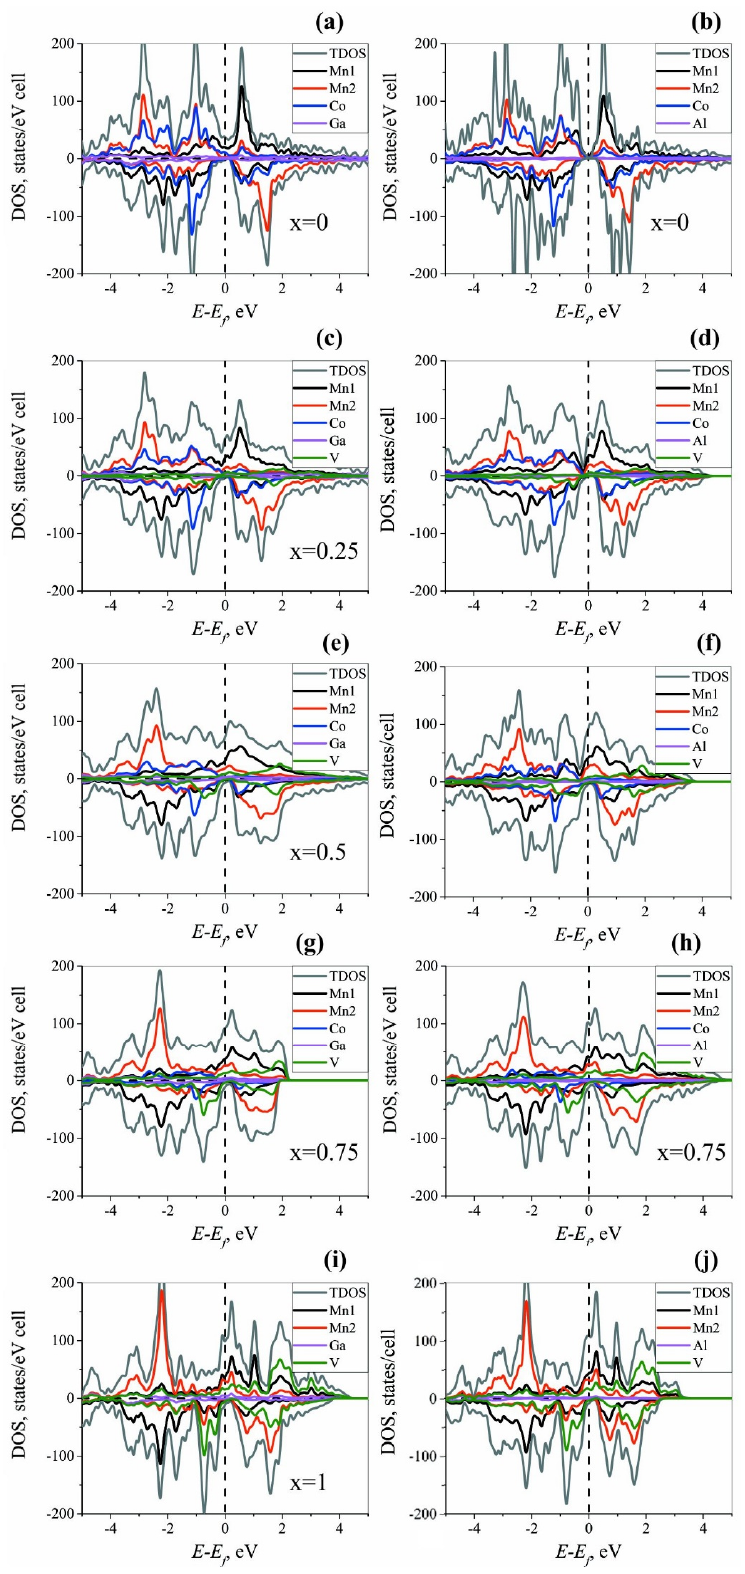
Figure 6. Electronic DOS of the Mn2Co1-xVxZ (Z = Ga, Al) Heusler alloys for the case of the XA structure. Panels ( a , c , e , g , i ) correspond to Mn 2 Co 1-x V x Ga alloys at x = 0, 0.25, 0.5, 0.75 and 1, respectively. Panels ( b , d , f , h , j ) correspond to Mn 2 Co 1-x VAl alloys at x = 0, 0.25, 0.5, 0.75 and 1,